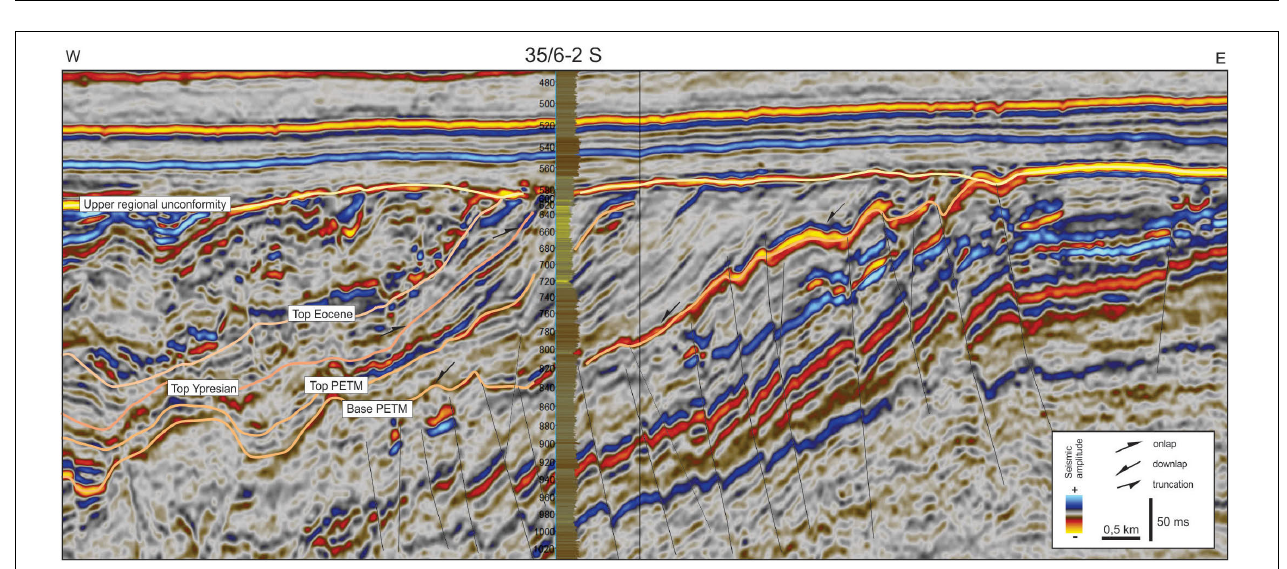
FIGURE 4 | Oblique view of co-blended root mean square (RMS) and variance attributes 20 ms above the Base Tertiary unconformity. The map shows the transition from siliciclastic dominated and remobilized deep-water channel and lobe complexes on the Måløy Slope, to large slides and mass-transport deposits on the Horda Platform and in the Stord Basin. The approximate basinward extent of Danian deep-water deposits is indicated by the white hatched line. The mass-transport deposits mostly comprise chalk and argillaceous shales. The present-day Norwegian coastline is show in gray.